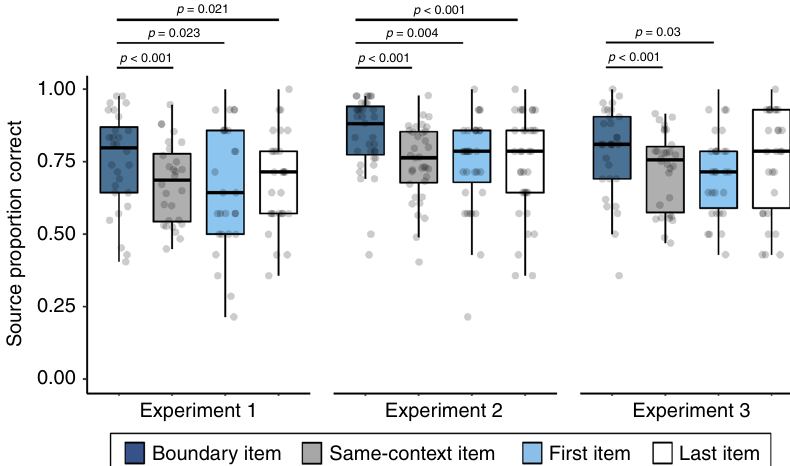
Fig. 4 Tone switches lead to better source memory for individual items and their accompanying sounds. During this source memory test, participants had to indicate whether each individually presented item had been paired with a tone played in their left or right ear during encoding. ‘ Last Item ’ refers to the last image presented in each 32-item list, whereas ‘ First Item ’ refers to the fi rst image presented in each 32-item list. ‘ Boundary Item ’ refers to the fi rst object appearing after a tone switch, or event boundary. Colored boxplots represent 25th – 75th percentiles of the data, the center line — the median, and the error bars — the s.e.m. Overlaid dots represent individual participants (Experiment 1: n = 34; Experiment 2: n = 35; Experiment 3: n = 30). A repeated- measures ANOVA was performed to test for differences in source memory accuracy by the four different item types. Displayed p -values re fl ect the results of follow-up, two-tailed Bonferroni-corrected pairwise comparisons. The results for the boundary compared to same-context trial comparisons from the fi rst experiment directly replicated two follow-up experiments. Source data are provided as a Source Data fi